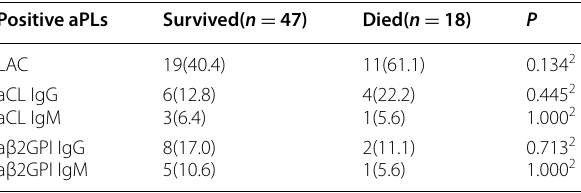
Table 5 aPLs and survival in COVID‑19 patients with thrombotic events